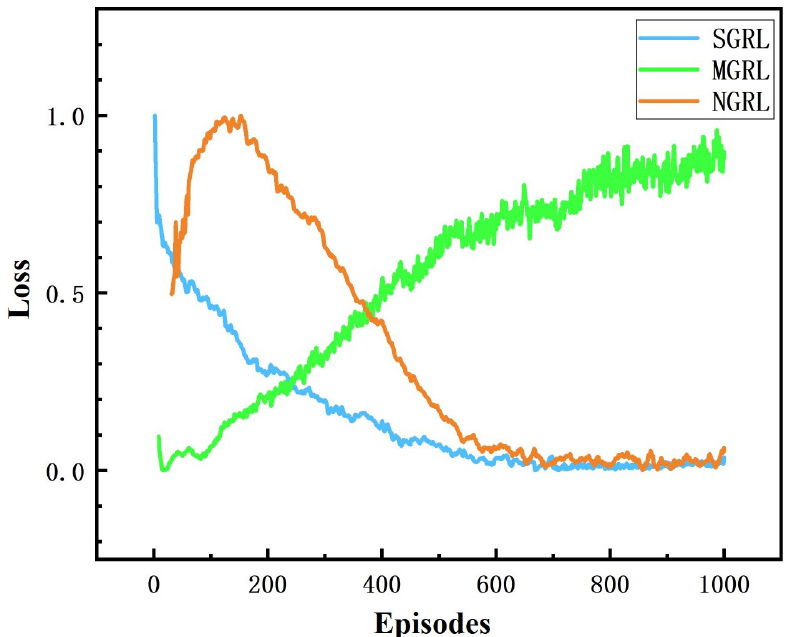
Figure 13. Diagram of loss. This value represents the difference between the real network and the ideal network.